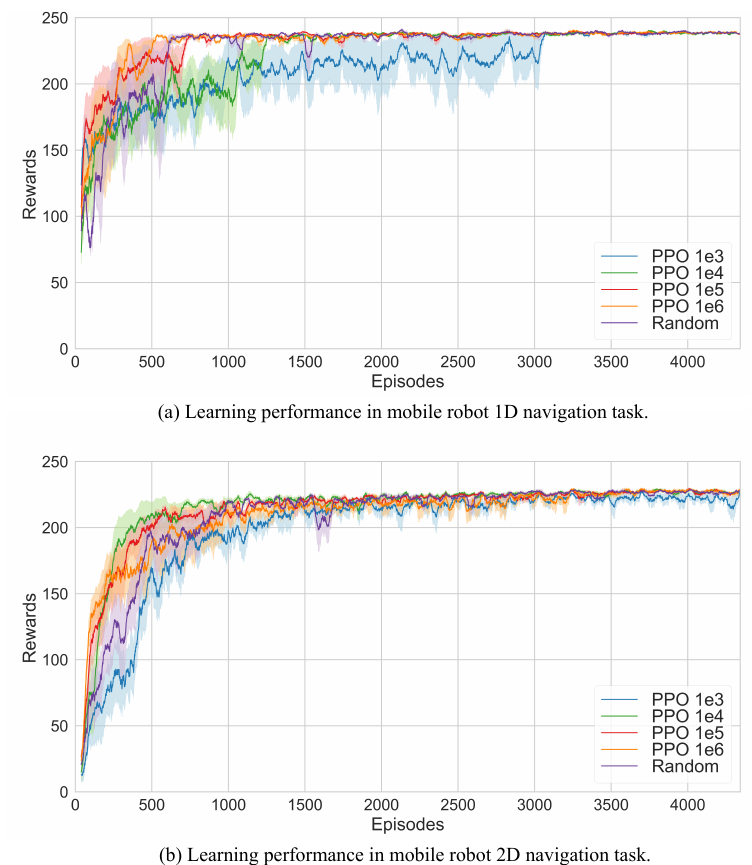
Figure 9. The influence of sampling methods in mobile robot navigation tasks based on PPO